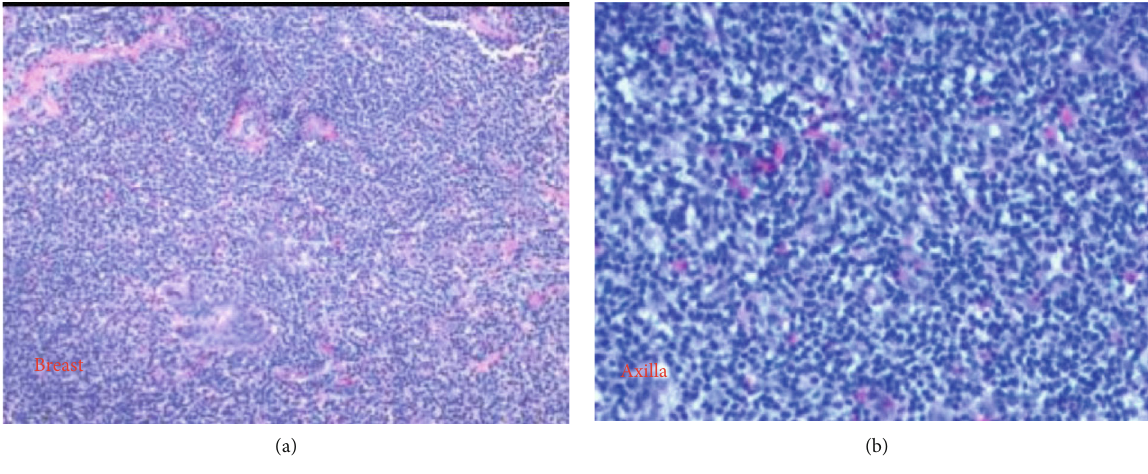
Figure 3: (a) Breast and (b) axillary